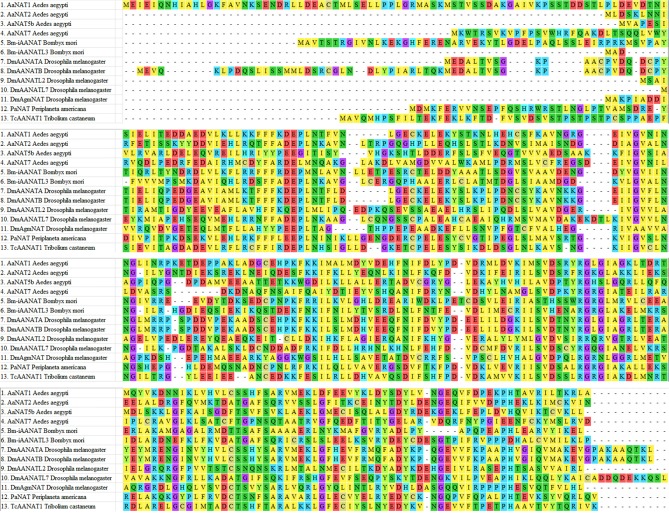
Sequence alignment of iAANATs demonstrating conserved regions. Residues are colored depending on acidic (red), basic (blue), polar (green), or hydrophobic (yellow). Cysteines are in gold and glycine is purple. Aedes aegypti – AaNAT1 (GenBank accession no. XP_001661400); AaNAT2 (GenBank accession no. XP_001663122); AaNAT5b (GenBank accession no. XP_001649916); Bombyx mori – Bm-iAANAT (GenBank accession no. NM_001079654.2); BmAANATL3 (GenBank accession no. NM_001190842.1); Drosophila melanogaster – DmAANATA (GenBank accession no. NM_079115.3); DmAANATB (GenBank accession no. NM_206212.1); DmAANATL2 (GenBank accession no. NM_135161.3); DmAANATL7 (GenBank accession no. NM_130653.3); DmAgmNAT (GenBank accession no. NP_572268.1); Periplaneta americana – PaNAT (GenBank accession no. BAC87874.1); TcAANAT1 – Tribolium castaneum (GenBank accession no. NM_001145908.1).